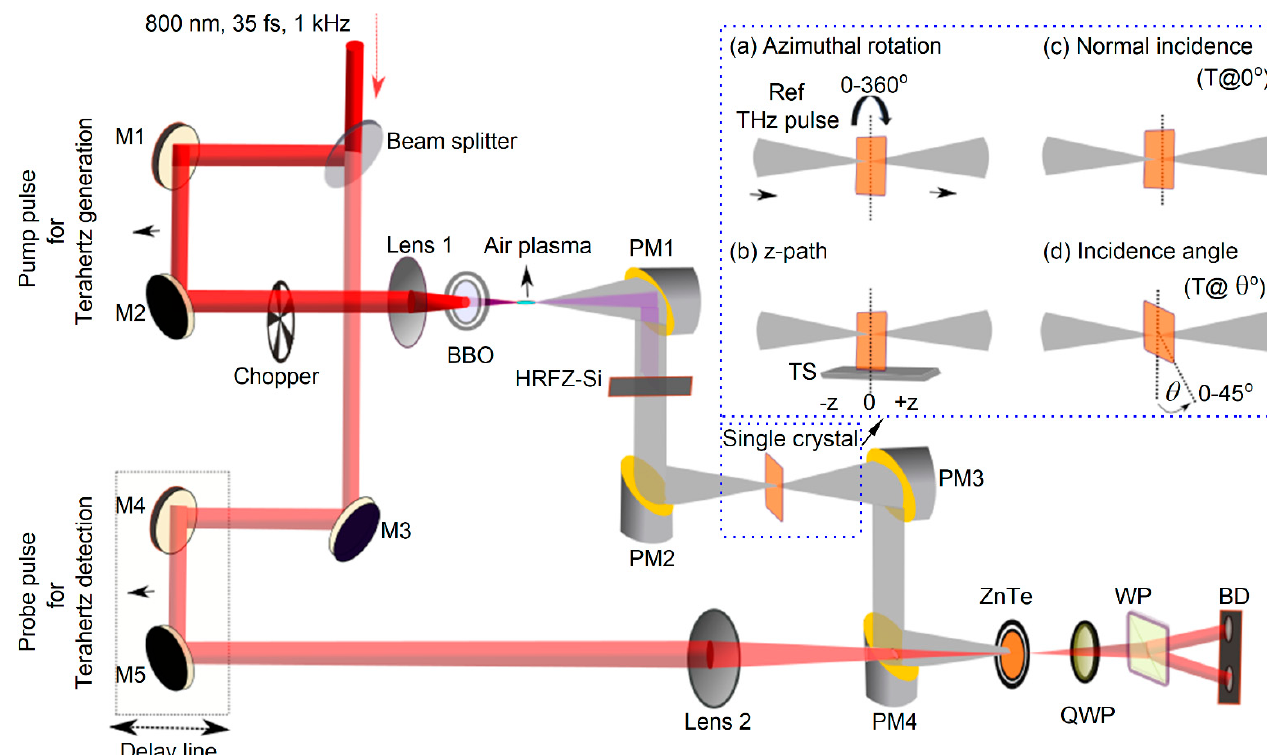
Figure 2. THz-TDS experimental layout. Beam splitter R:T (90:10), BBO (type 1, 0.2 mm), ZnTe (110, 1 mm thick), lens 1 (f = 150 mm), lens 2 (f =300 mm), M1–M5: mirrors, PM1–PM4: off-axis parabolic mirrors, TS: translation stage, QWP: quarter waveplate, WP: Wollaston prism, and BD: balanced diodes. Insets show at normal incidence of input THz pulse ( a ) single crystal azimuthal orientation and ( b ) single crystal moved along the z-path. Representation of ( c ) incident THz pulse at normal